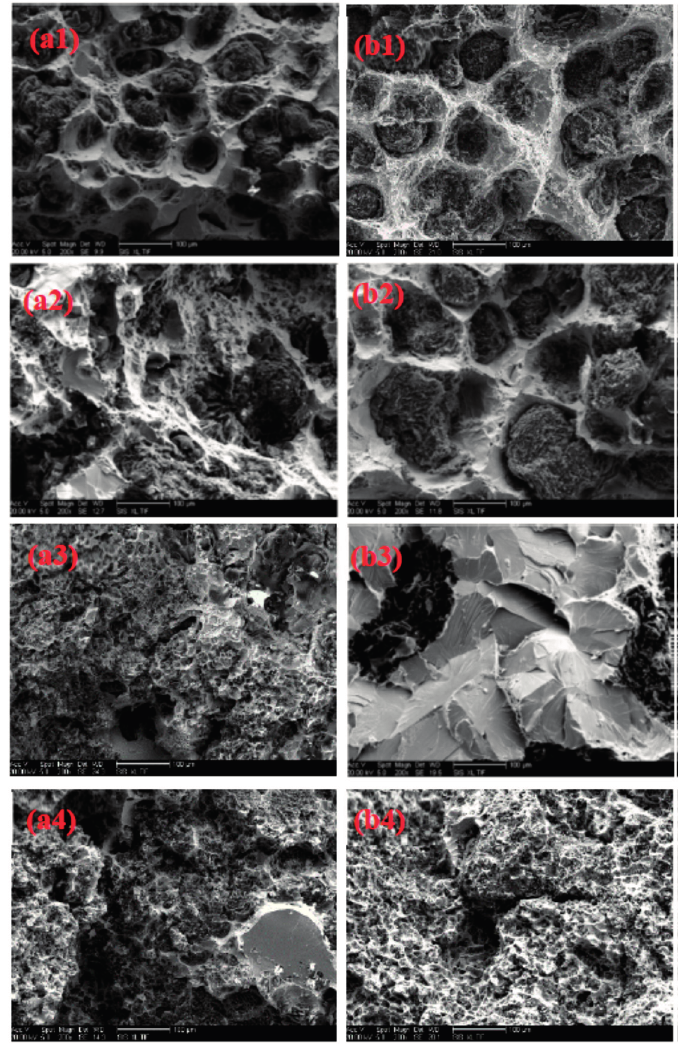
Figure 7. The fracture toughness fracture morphology at four positions of two castings ( a1 ) specimen A1; ( a2 ) specimen A2; ( a3 ) specimen A3; ( a4 ) specimen A4; ( b1 ) specimen B1; ( b2 ) specimen B2; ( b3 ) specimen B3; and ( b4 ) specimen